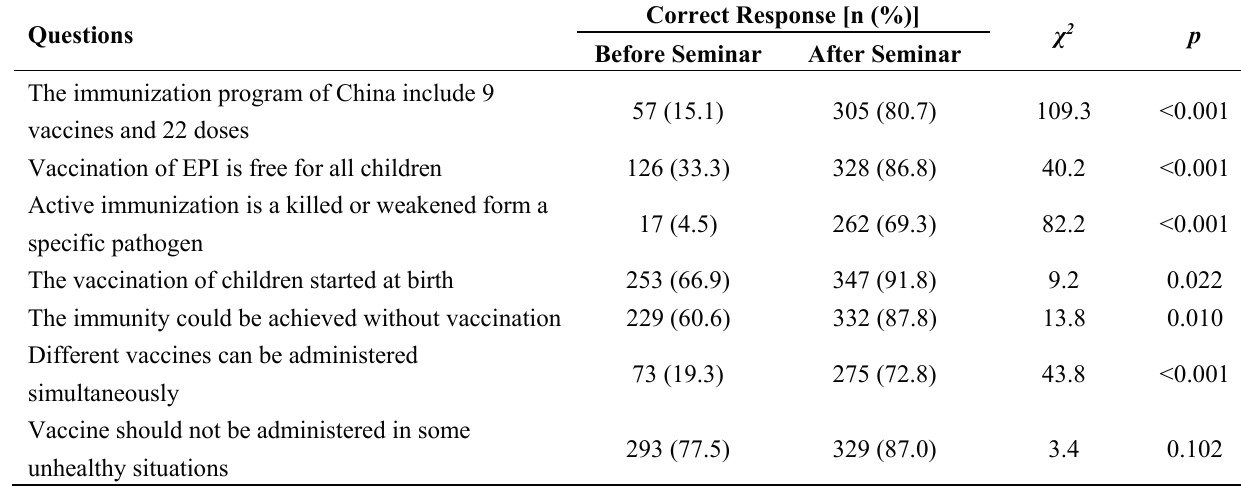
Table 2. Comparison of caregivers’ knowledge level on vaccination before and after health education seminar (N =